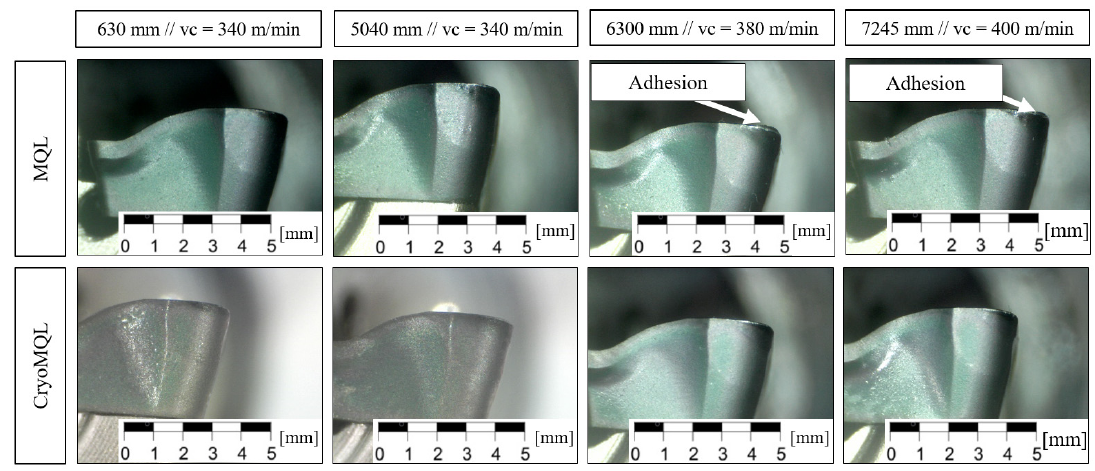
Figure 2. Tool wear due to cu tt ing length.